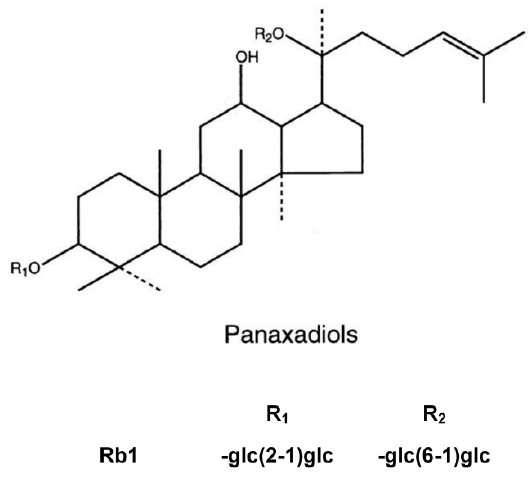
Figure 1. The molecular structure of Rb1.